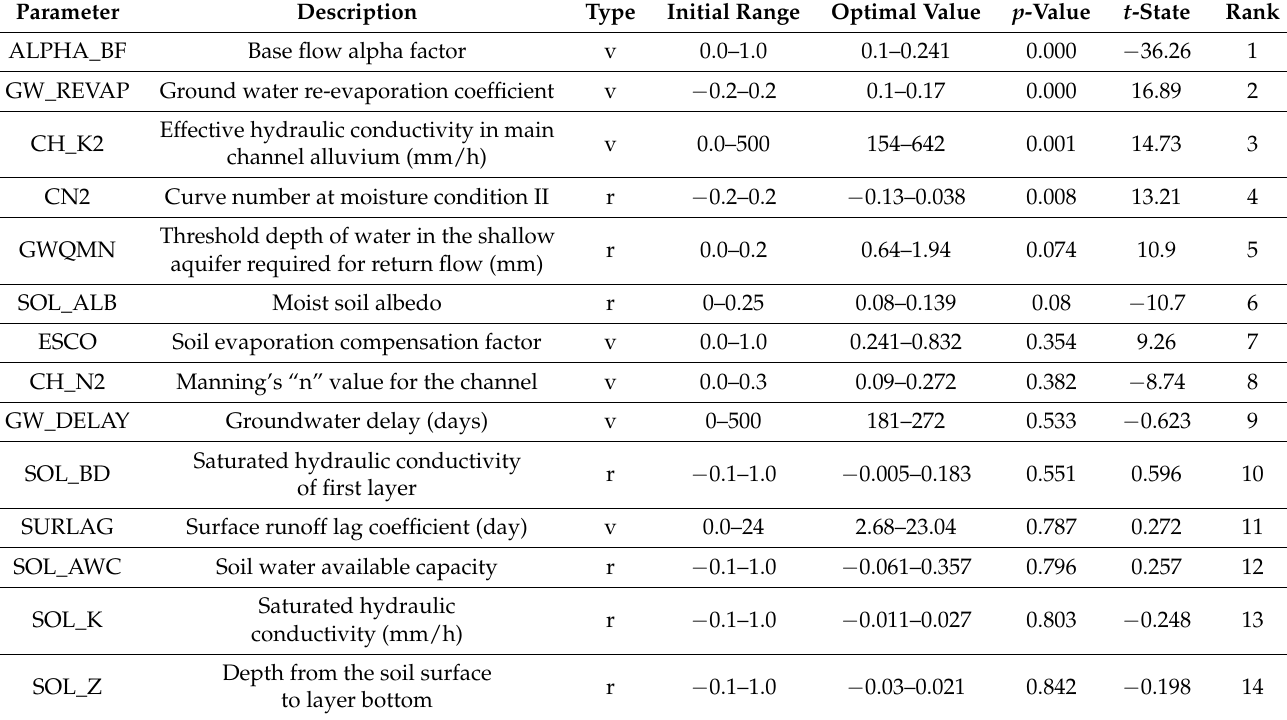
Table 2. Parameters used for calibration with optimum